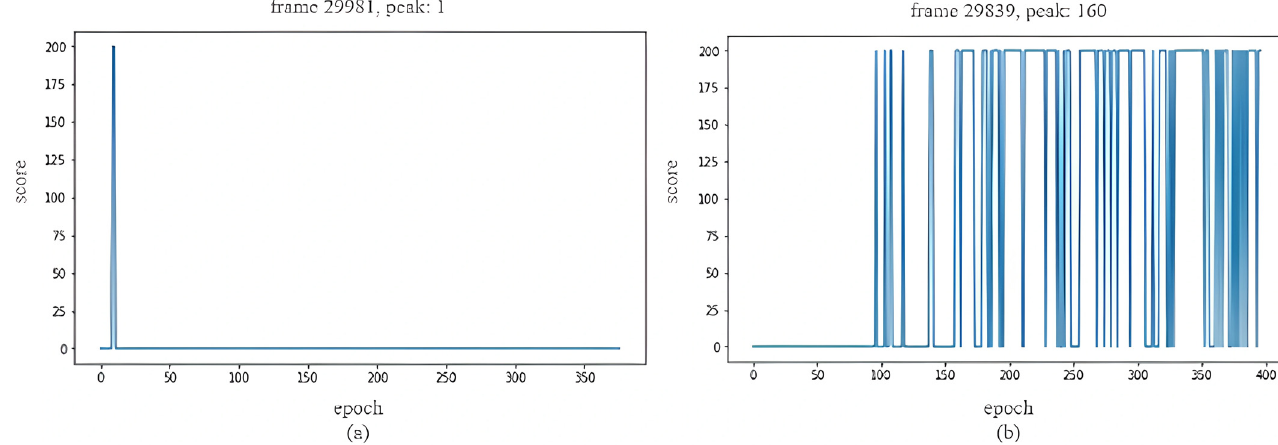
Figure 11. Pouring task behavior clone training. ( a ) One peak. ( b ) Multiple peaks.